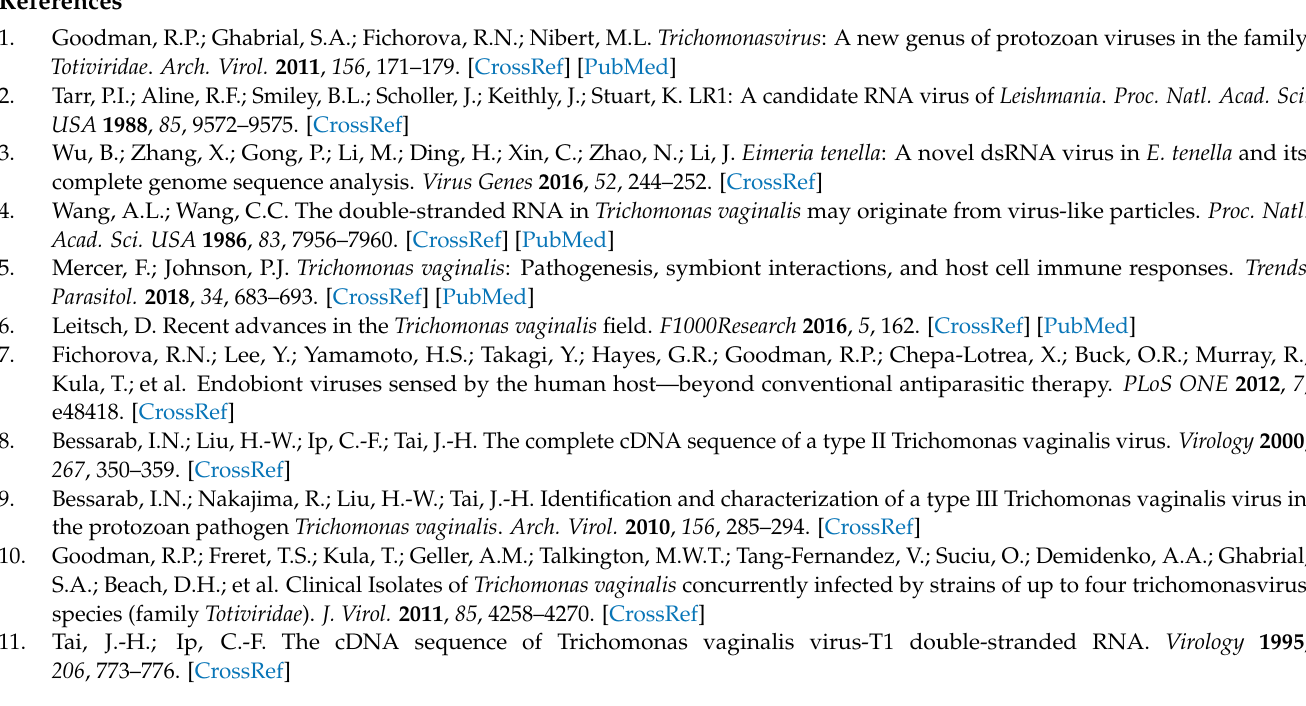
Table S8: Pairwise identity matrix of TVV5 CP/RdRp aa sequences, File S1: TVV genome nt sequences newly assembled from SRA datasets, File S2: GenBank accession numbers of other sequences used for phylogenetic analyses, File S3: Alignment of CP/RdRp aa sequences used for the phylogenetic analyses represented in Figure 1, File S4: Newick tree file represented in Figure 1 for 100 standard bootstraps, File S5: Newick tree file represented in Figure 1 for 100 standard+transfer bootstraps, File S6: Newick tree file represented in Figure 1 for 1000 ultrafast bootstraps, File S7: Newick tree file represented in Figure 1 for 1000 ultrafast+transfer